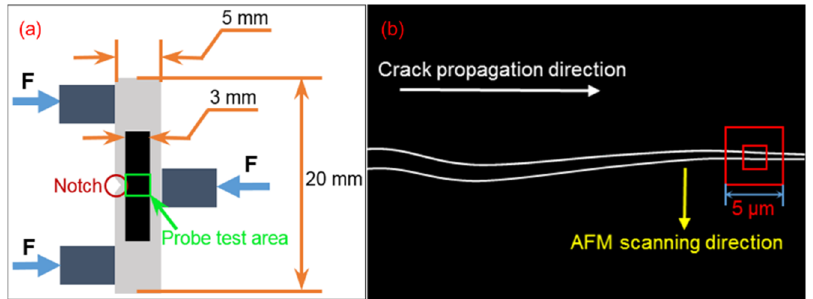
Figure 3. Schematic of the three-point bending test and specimen geometry ( a ) and schematic of the experimental scheme ( b ).